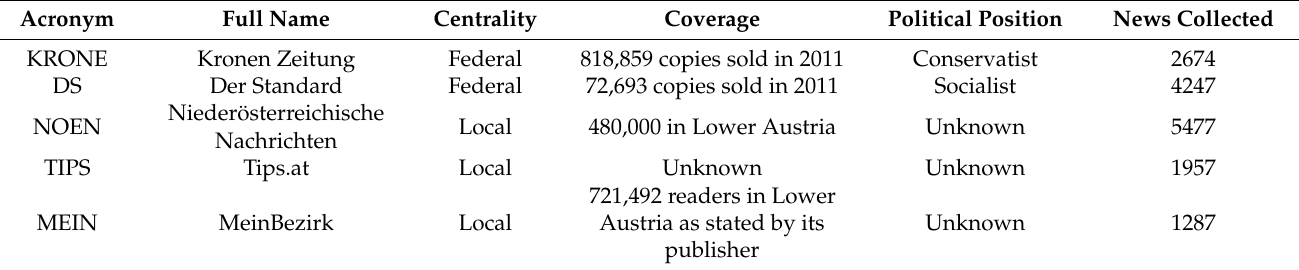
Table 2. Summary of the key features of the five newspapers analyzed and selected as data sources for our